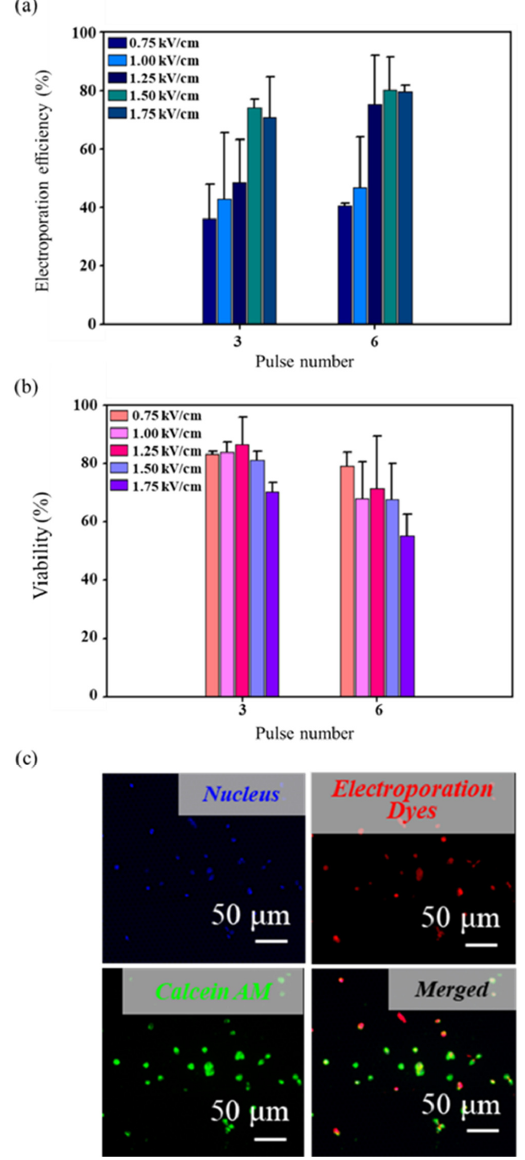
Figure 2. Transfection of fluorescent dyes in 1601 cells. ( a ) The electroporation efficiency of 1601 cells under different electric field strengths and pulse numbers (n = 3 for every trial). ( b ) The cell viability after electroporation under different electric field strengths and pulse numbers (n = 3 for every trial ) . ( c ) Typical fluorescent images of successful electroporation with viability maintained.